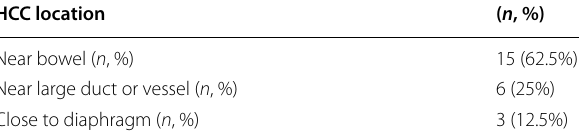
Table 3 Indications for ultrasound-guided LARFA